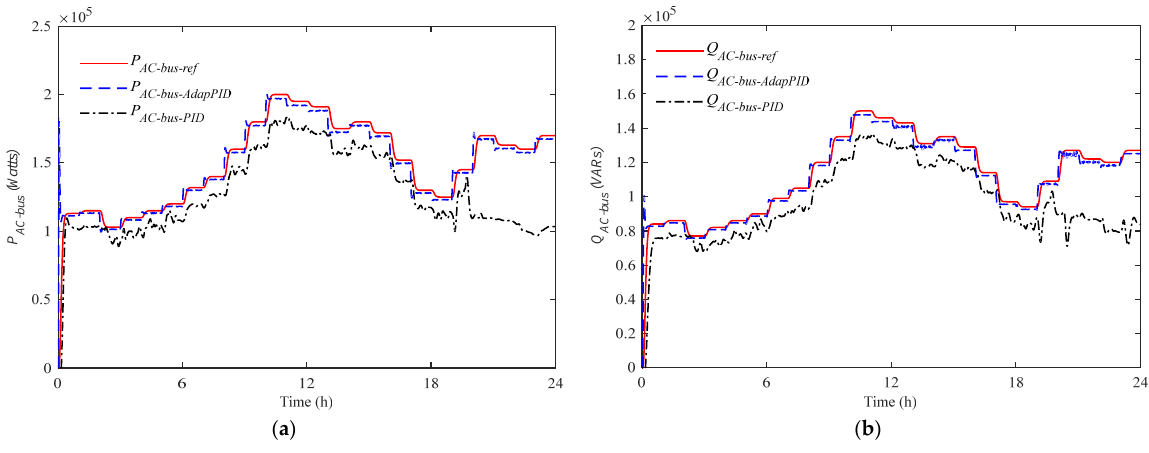
Figure 4. AC bus ( a ) Active power; ( b ) Reactive power.